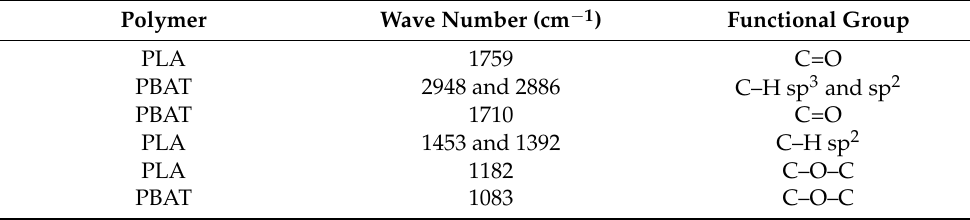
Table 4. Absorption band in the infrared region for PBAT and Figure 4. Images of polymeric fibers of PBAT/PLA ( a ) with 10% TiO 2 -R; ( b ) with 1% Fe 3 O 4 ; ( c ) pure; and ( d ) with 10% TiO 2 -R + 1% Fe 3 O 4 .